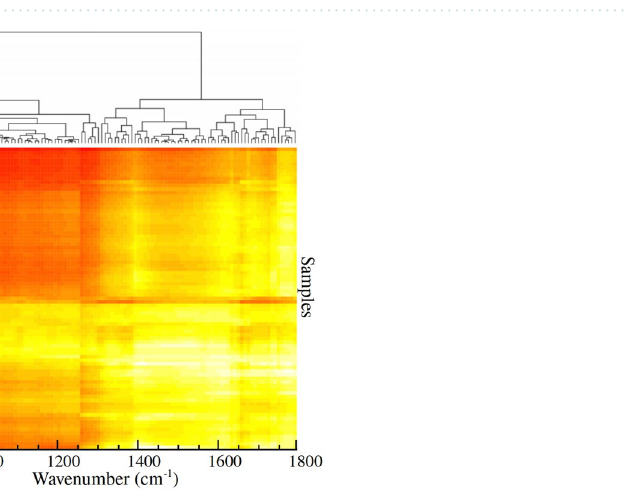
Figure 4. Discrimination performance of micro-FTIR. PLS-DA classification performance using different number of components following accuracy, R mixture/negative, ( c ) groups. Regression coefficients and calculated response in PLS-DA for sample classes are shown in ( b , d ), respectively.